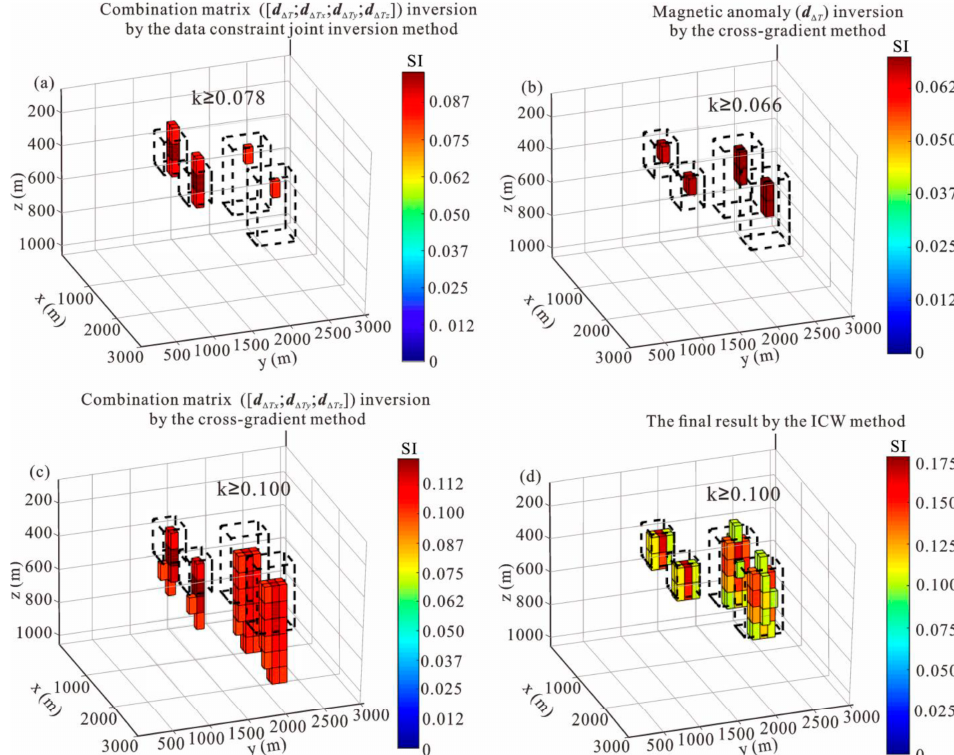
Figure 10. volume-rendered images by different inversion methods. ( a ) volume-rendered image ] ) inversion by the data constraint joint inversion of the combination matrix ( [ d ∆ T ; d ∆ T ; d ∆ T ; d ∆ T x y z method. ( b ) volume-rendered image of magnetic anomaly ( d ∆ T ) inversion by the cross-gradient ] ) inversion by the method. ( c ) volume-rendered image of combination matrix ( [ d ∆ T ; d ∆ Tx ; d ∆ T y cross-gradient method. ( d ) volume-rendered image of the final result by the ICW